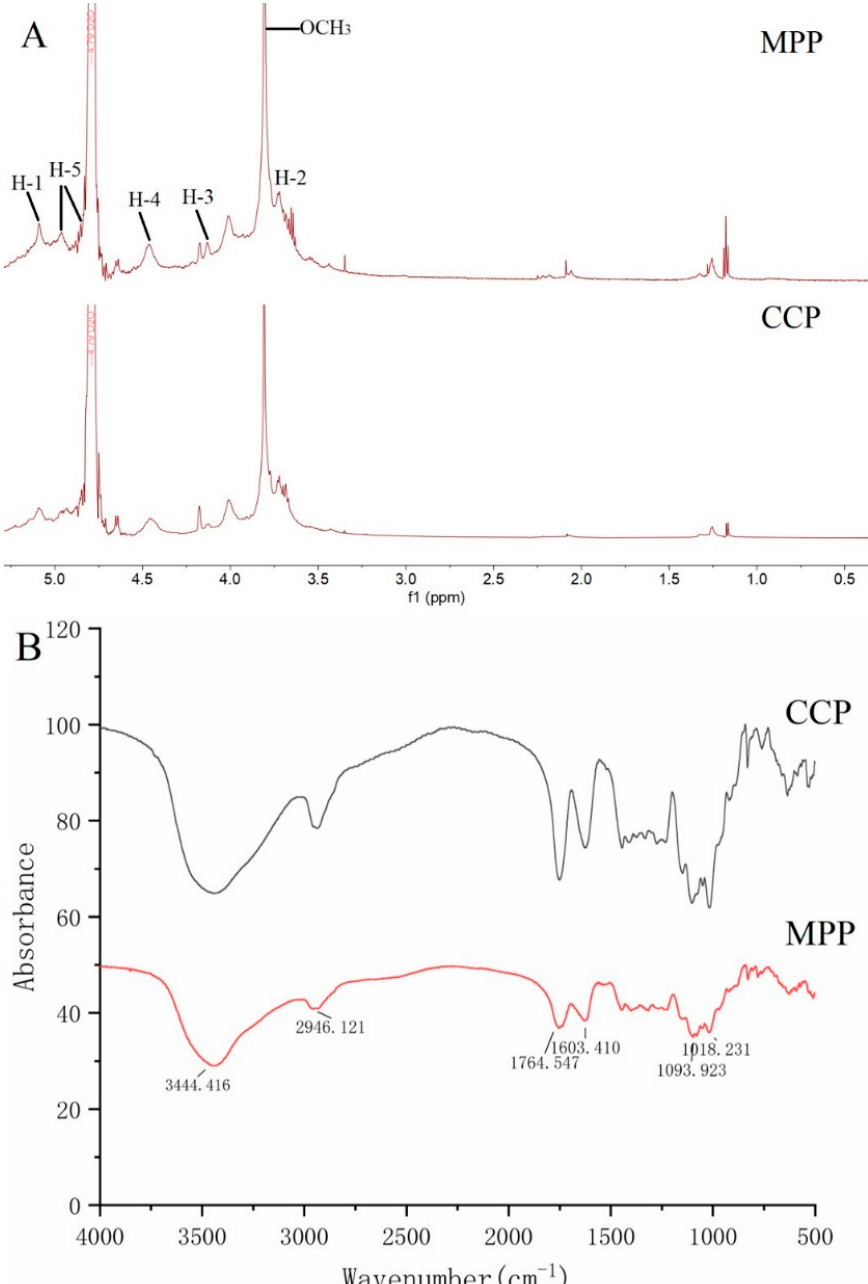
Figure 2. 1 H NMR spectrum ( A ) and FTIR spectrum ( B ) of MPP and Figure 2. 1H NMR spectrum (A) and FTIR spectrum (B) of MPP and CCP.